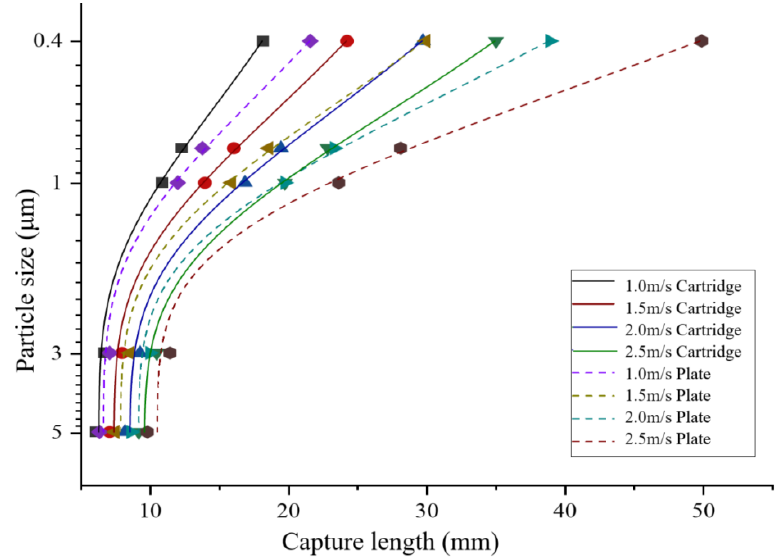
Figure 8. Theoretical STL required by the micro-electrostatic filters to capture particles of various sizes.